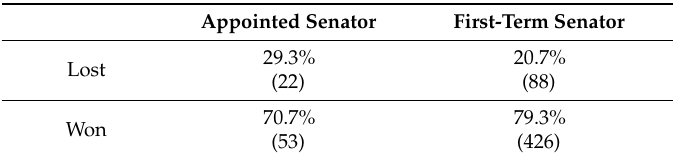
Table 3. Percentage of Candidates Winning